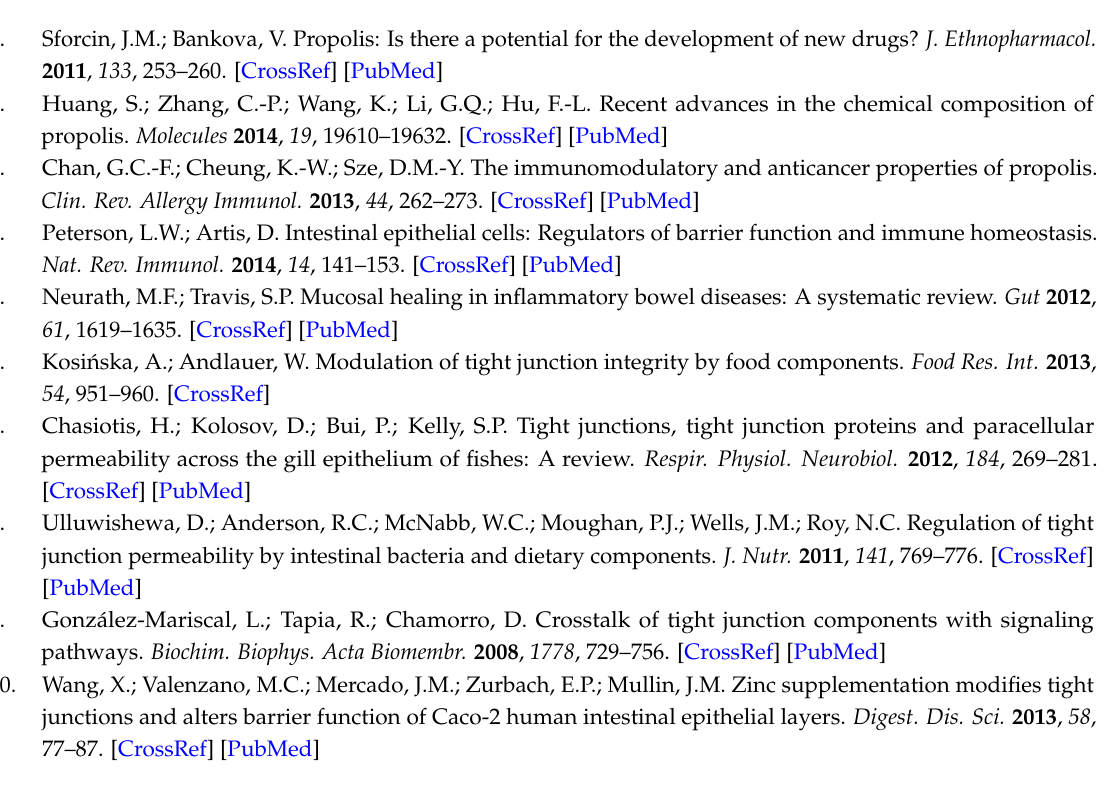
Supplementary methods, Table S1: Composition of the diet, Figure S1: Effects of tBHP on treatment on the distribution of tight junction proteins (ZO-1 and occludin), as well as tight junction morphological ultrastructure in Caco-2 cells, Figure S2: Time course effect of PPE treatment on the activations of AMPK, Akt, ERK and p38, Figure S3: Effects of oral administration of PPE on rat colon